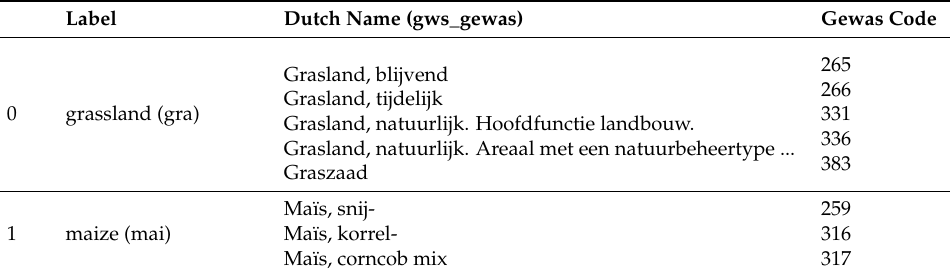
Table A1. Aggregation of the crops in 8 main